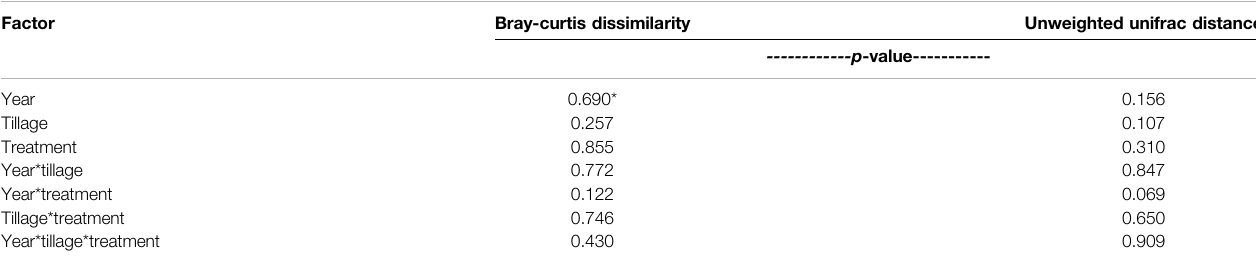
TABLE 4 | PERMANOVA results for Bray-Curtis dissimilarity and unweighted unifrac distance.